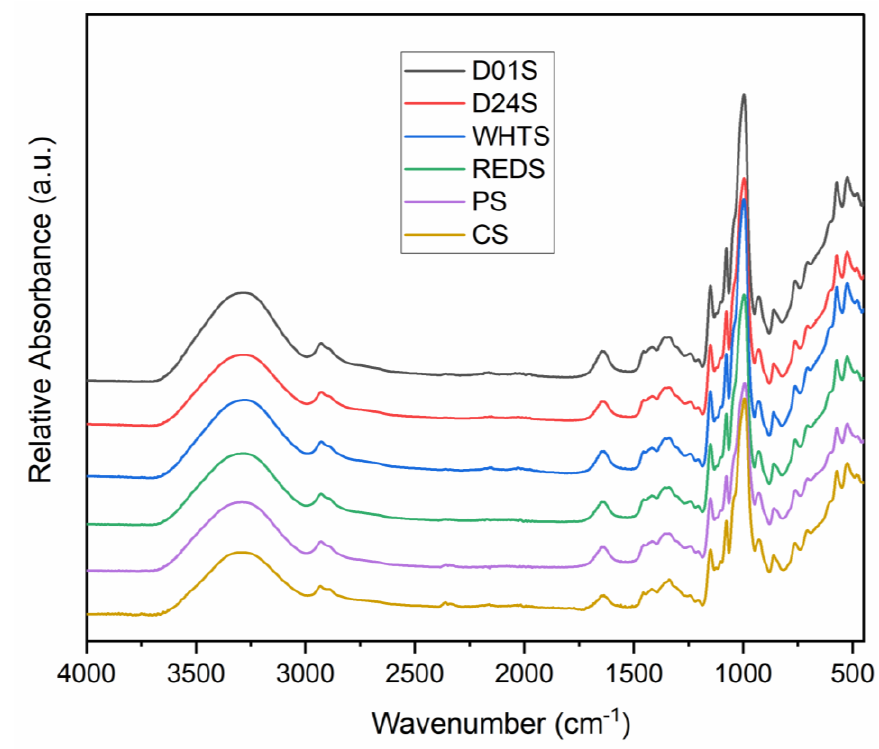
Figure 6. FTIR spectra of starches from four cultivars of anchote (D01S = Desta 01 starch, D24S = Desta 24 starch, WHTS = white starch, and REDS = red starch). Potato (PS) and cassava (CS) starches are included as references.